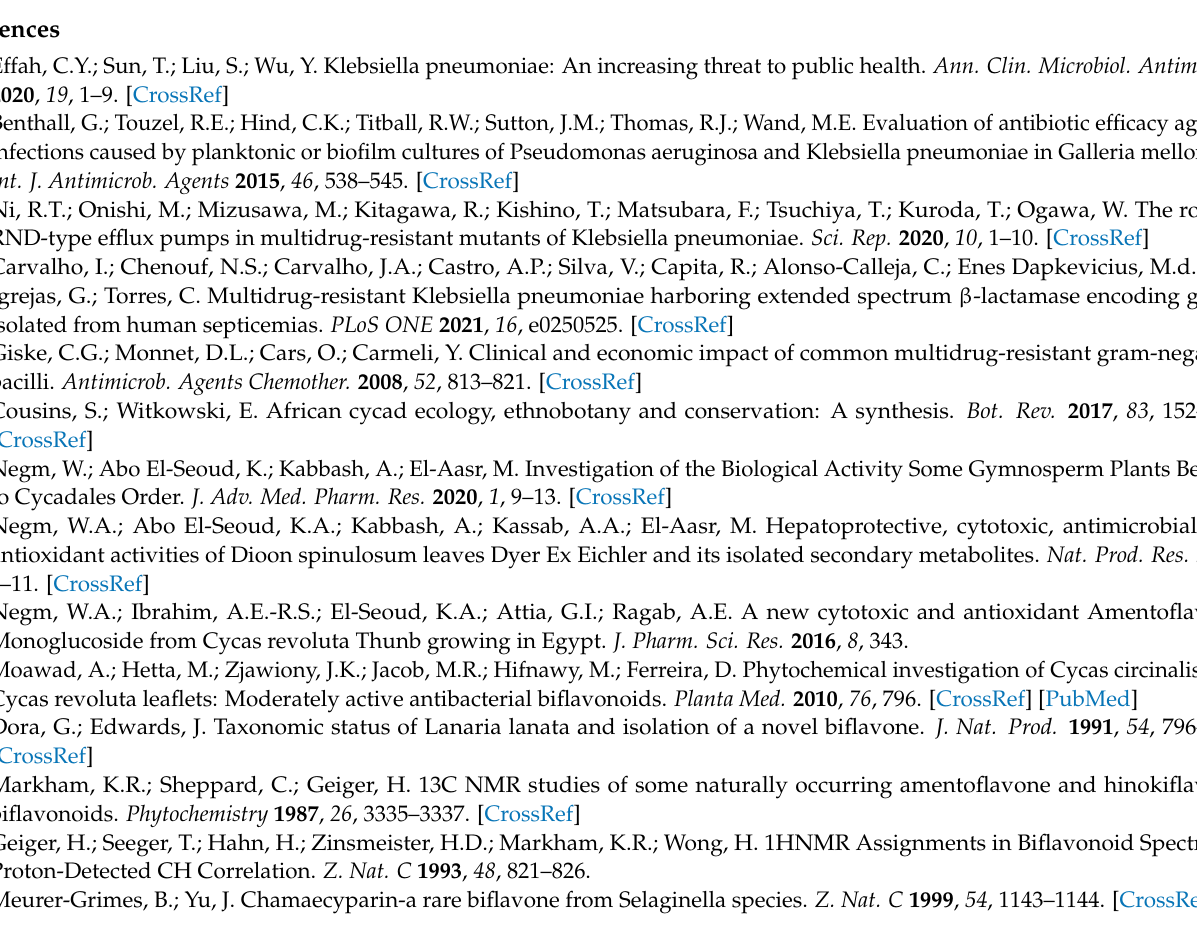
of compound 3 ; Figure S3: 13 C-NMR spectrum of compound 3 ; Figure S4: HMBC spectrum of compound 3 ; Figure S5: COSY spectrum of compound 3 ; Figure S6: ESI mass spectrum of compound 3 ; Scheme S1: Column chromatography of methylene chloride fraction of C. thouarsii